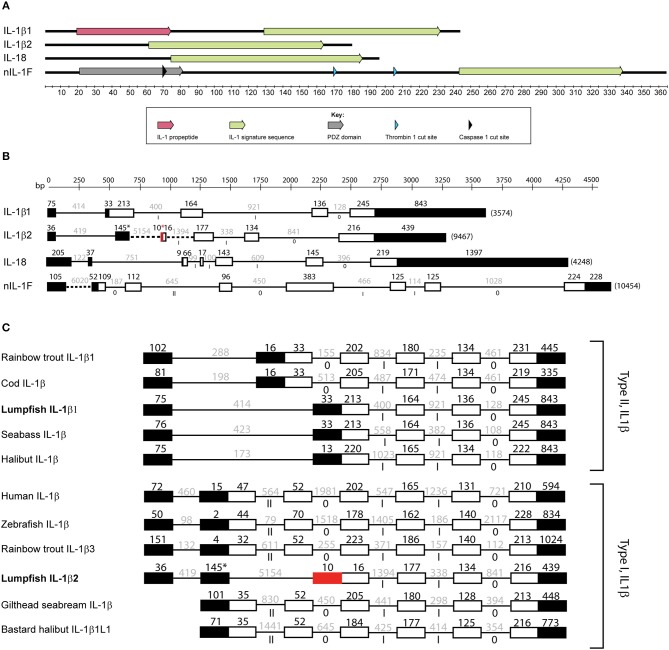
Molecular characterization of IL-1 ligands. (A) Domain and cut site prediction of IL-1β1, IL-1β2, IL-18, and nIL-1F. The x-axis is the number of amino acids from N-terminus to C-terminus of the proteins. IL-1 family domain is defined as IPR00097, IL-1 propeptide as IPR00302, and PDZ domain by IPR001478. (B) Exon/intron structure of the IL-1 ligands. Black boxes are non-coding exons, white boxes are coding exons. Red exon indicates remnants of the deleted exon in lumpfish IL-1β2. Thin lines are introns. Dotted lines are not to scale. (C) Non-coding exons (black boxes), coding exons (white boxes) for selected IL-1 β type I and type II sequences. Roman numerals represent intron phases.